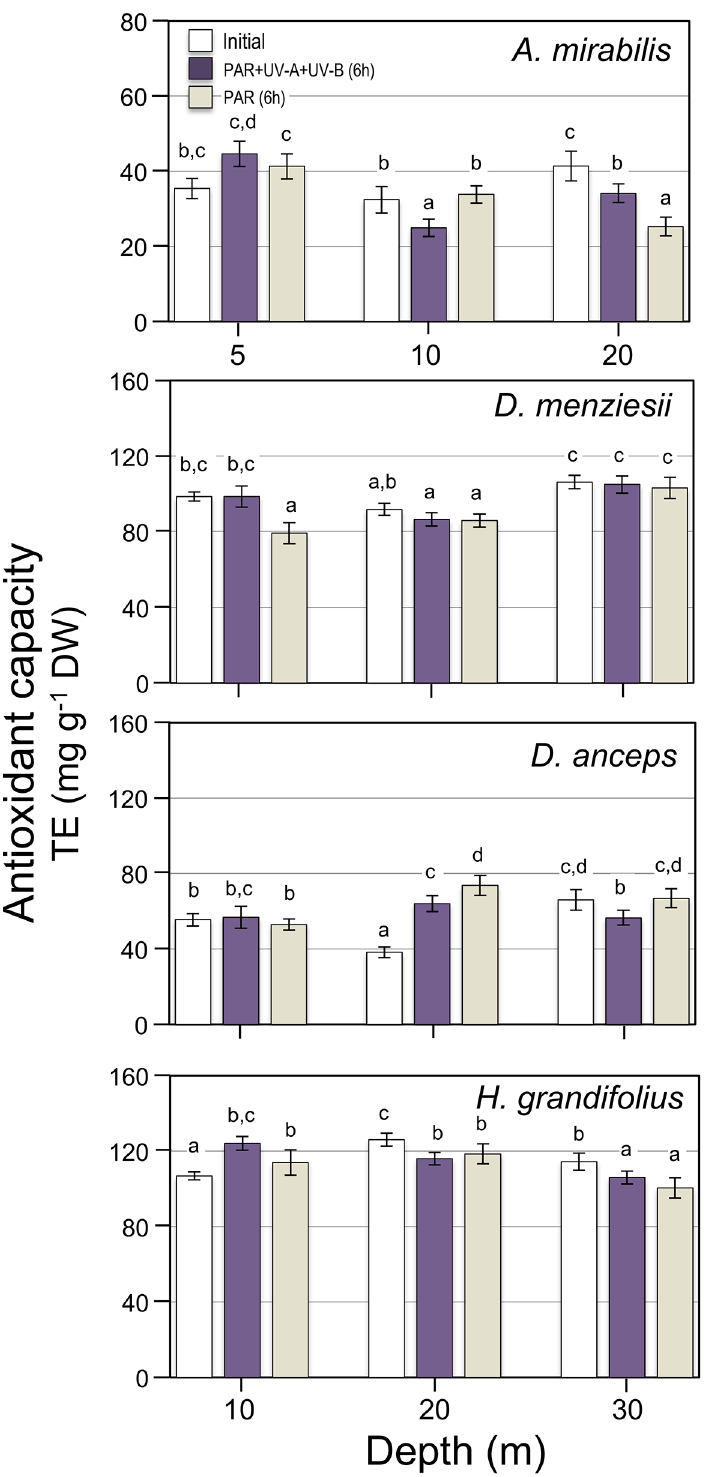
Fig 7. Effect of UV exposure on the antioxidant capacity measured in four brown algae collected at different depth in Fildes Bay. Algae were exposed for 6 h to PAR+UV-A+UV-B and PAR conditions (20 μ mol m -2 s -1 for PAR, 3 W m -2 for UV-A and 0.25 W m -2 ). Initial is the time cero before the 6 h exposure to UV radiation. Values are means ± S.D., n = 3. Similar letters connect homogeneous mean groups for each species after two-way ANOVA and Tukey ’ s HSD. doi:10.1371/journal.pone.0134440.g007 PLOS ONE | DOI:10.1371/journal.pone.0134440 August 7,